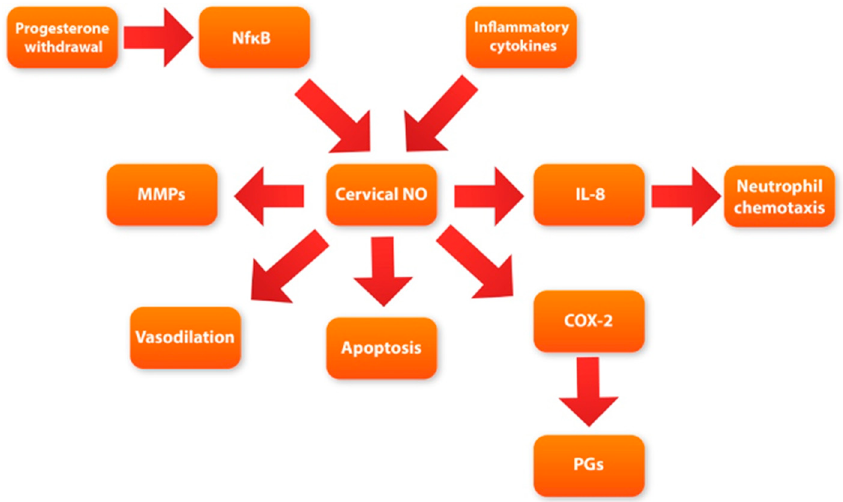
Figure 2. Diagram showing potential role of nitric oxide (NO) in cervical ripening process